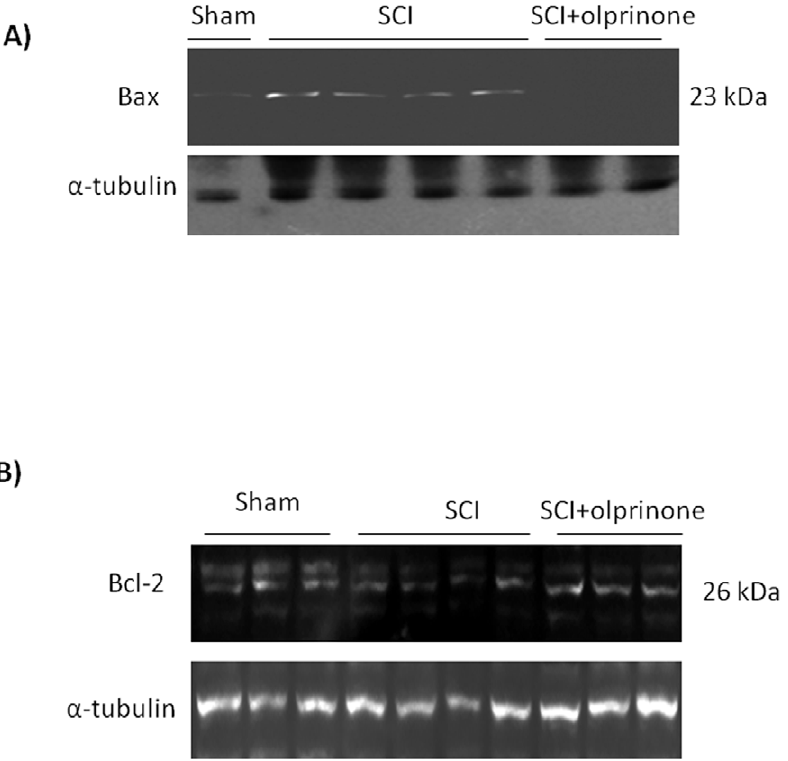
Figure 10. Effects of olprinone on intrinsic apoptotic pathway. SCI caused, at 24 h, an increase in Bax expression as evidenced by Western blot analysis ( A ). Olprinone treatment (0,2 mg/kg) reduced the degree of positive staining for Bax in the spinal cord ( A ). Moreover, a basal level of Bcl- 2 expression was detected in spinal cord from sham-operated mice ( B ). Twenty-four hours after SCI, Bcl-2 expression was significantly reduced in spinal cord from SCI mice. Olprinone treatments (0,2 mg/kg, 1 h and 6 h after SCI induction) significantly reduced the SCI-induced inhibition of Bcl-2 expression ( B ).